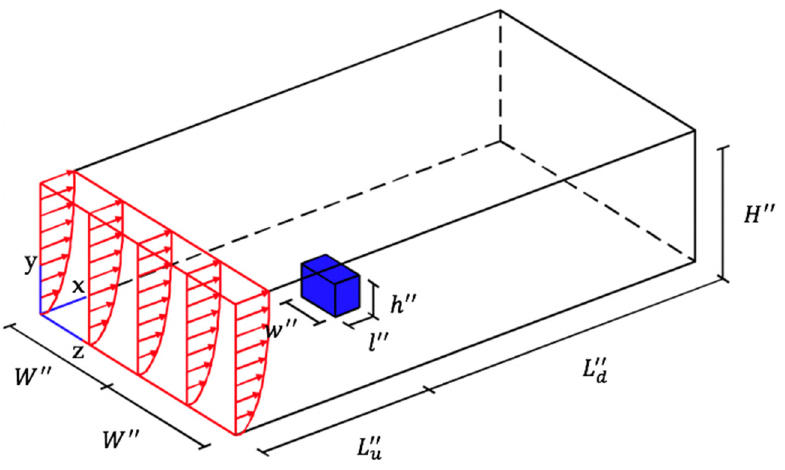
Figure 4. Schematic configuration of the computational domain and the surface ‐ mounted building.